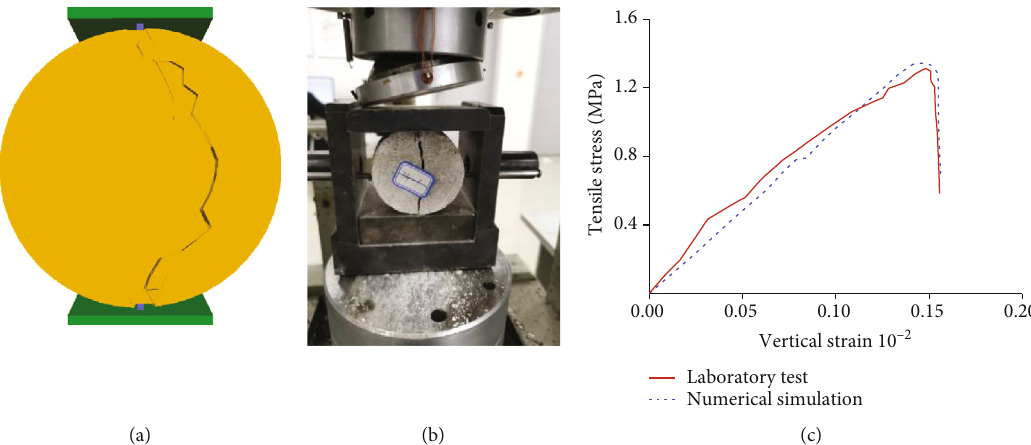
Figure 7: Check of Brazilian splitting test. (a) Numerical model of splitting test. (b) Splitting test in laboratory. (c) Tensile test curves of